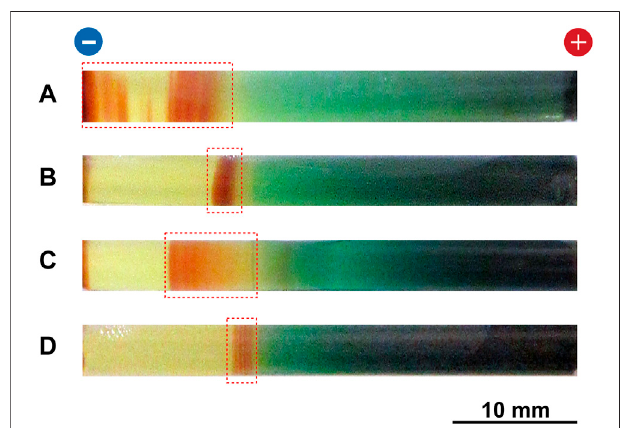
FIGURE 11 | Typical multicolored patterns formed at 25 ° C in the Cu – Fe PBA system under various cyclic alternating voltage conditions. The